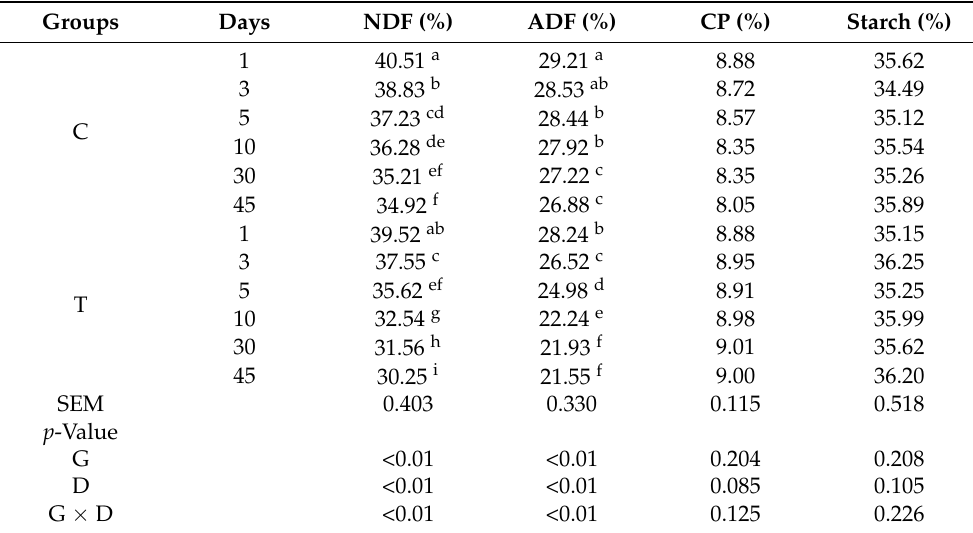
Table 2. Dynamic changes in the neutral detergent fibre (NDF), acid detergent fibre (ADF), crude protein (CP), and starch contents in the two groups during the ensiling process.